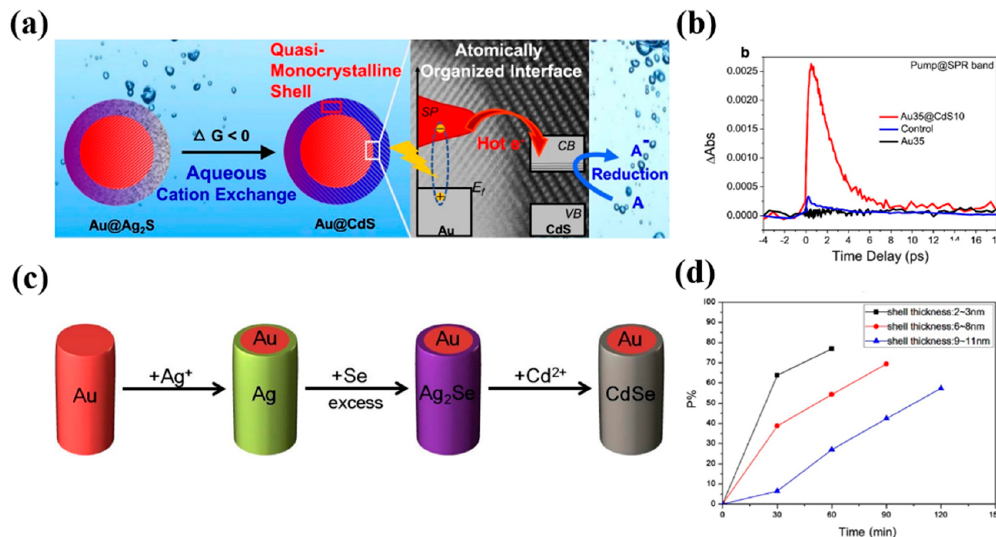
Figure 7. The synthesis of high quality heterostructures. ( a ) The scheme of the method of aqueous cation exchange for Au@CdS heterostructures and ( b ) the transient absorption spectrum of three types of structures, Au35@CdS10 (the sizes of the Au core and CdS shell are 35 nm and 10 nm, respectively.), Control (Au35@CdS10 prepared by conventional methods) and Au35 (pure Au sphere with a diameter of 35 nm), pumped at the center surface plasmon resonance (SPR) band. ( a , b ) Reproduced with permission. [92] Copyright 2018, Elsevier Ltd. ( c ) The scheme in the synthesis of cylindrical Au@ CdSe heterostructures and ( d ) the rates of degradation of MB with different thicknesses of the CdSe shell. ( c , d ) Reproduced with permission. [93] Copyright 2018, Elsevier Ltd.